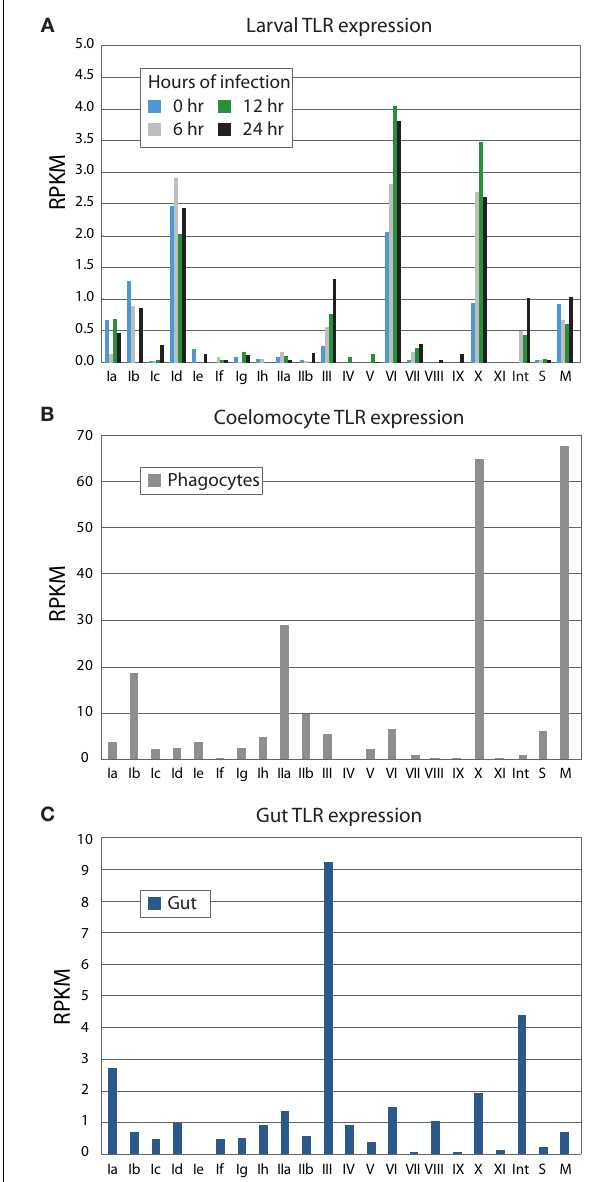
FIGURE 5 |TLR subfamilies are differentially expressed. RNA-Seq was used to analyze gene expression from larvae (A) , immune cells (B) , and gut (C) . Phagocytic coelomocytes and gut were isolated from an animal 12h after intracoelomic injection of a gut bacteria preparation. Larvae were exposed to V. diazotrophicus for 0, 6, 12, and 24h, and collected for transcriptome sequencing. RPKM values were calculated for each of the TIR domains; the average RPKM for each group is shown.The sccTLR subfamilies correspond to those shown in Figure 2 . Note that the scales are different for each graph.The divergentTLRs are indicated as follows: M, mccTLRs; S, short; Int, intron-containing ( Figure 1 ). In phagocytic coelomocytes,TLRs from the Ib, IIa, and X subfamilies, as well as the mccTLR genes are most highly expressed. In contrast, the IIITLRs are primarily expressed in the gut tissue.TheTLRs are expressed at lower levels in the larvae, and little change inTLR expression in the larvae is observed in response to bacterial challenge.The predominantly expressed families at the larval stage are Id andVI, are different than those expressed in coelomocytes.